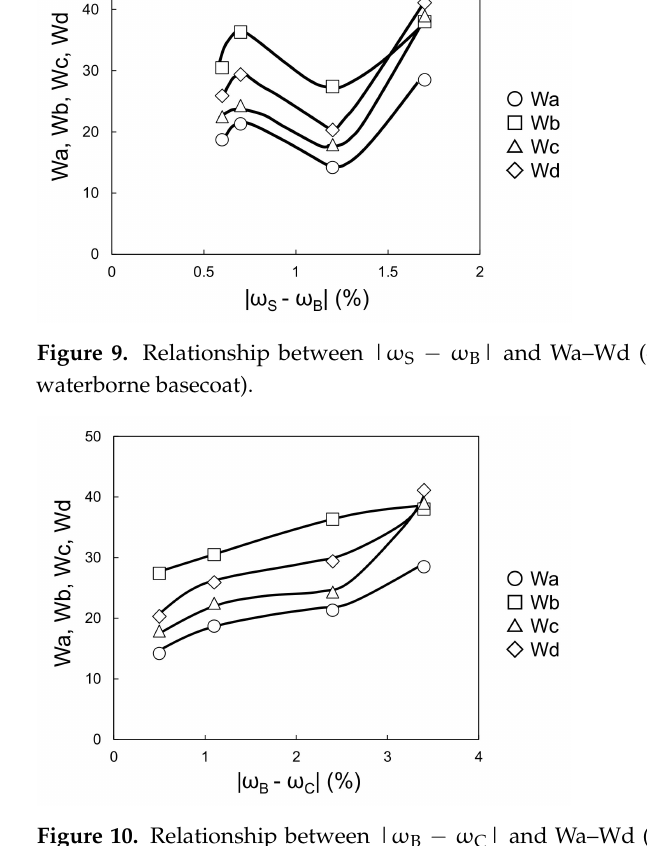
Figure 10. Relationship between | ω B − ω C | and Wa–Wd (changing melamine resin content in waterborne